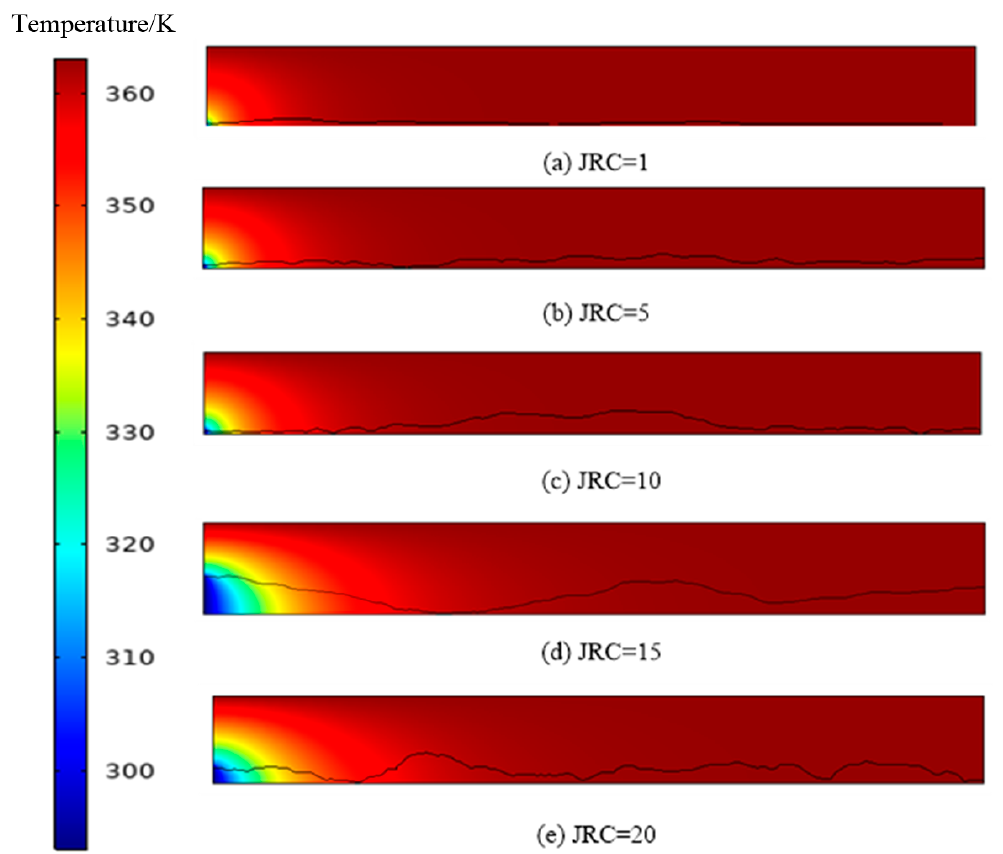
Figure 5. Temperature contour of fracture profile with different JRC (1–20).